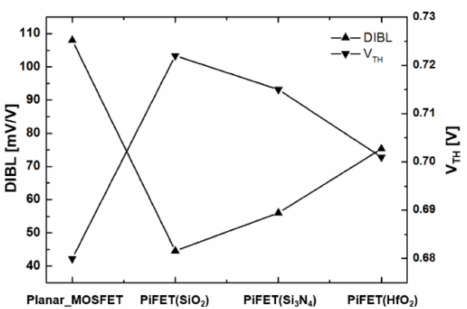
Figure 7. Simulation results for the DIBL and the threshold voltage for the planar MOSFET and PiFETs with a silicon film thickness of 15 nm and the buried insulators of SiO 2 , Si 3 N 4 , and HfO 2 materials.